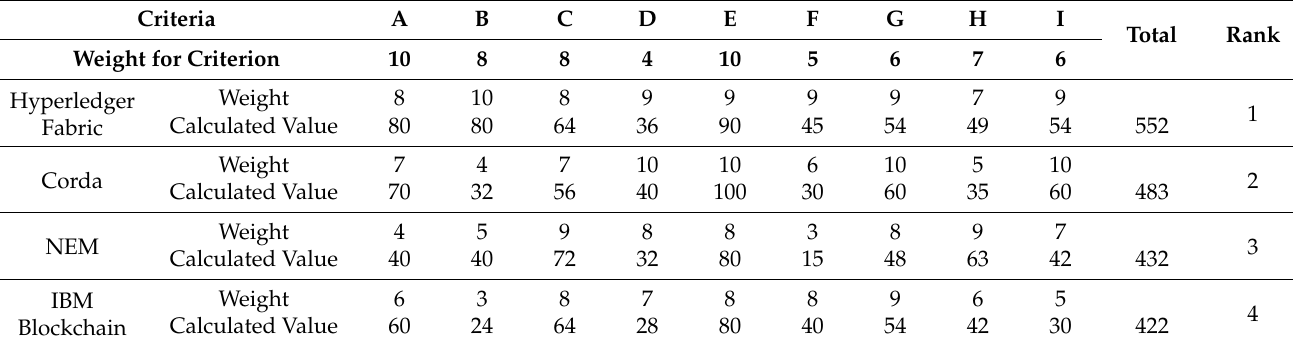
Table 2. Top four blockchain platforms suitable for the system requirements based on SMART evaluation (adapted from [61]). Criteria